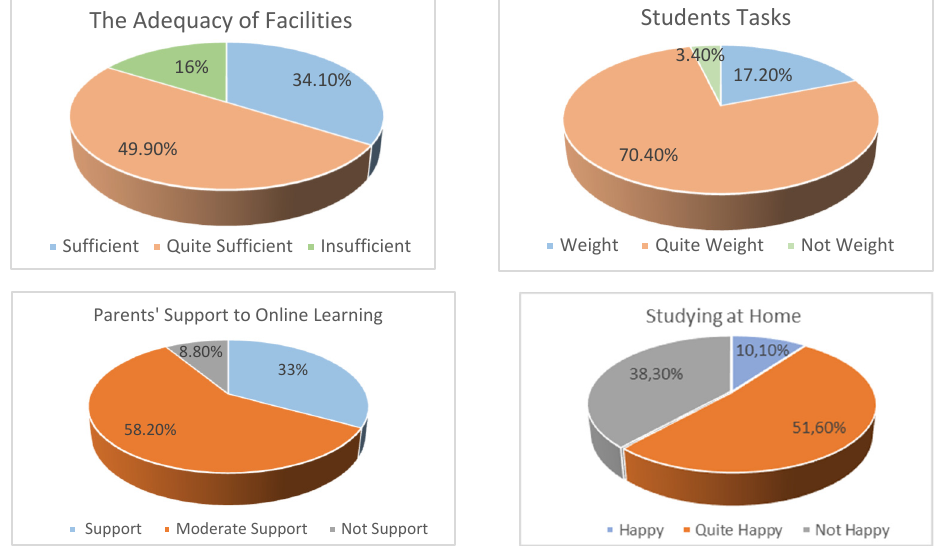
Figure 2. Preliminary research results .